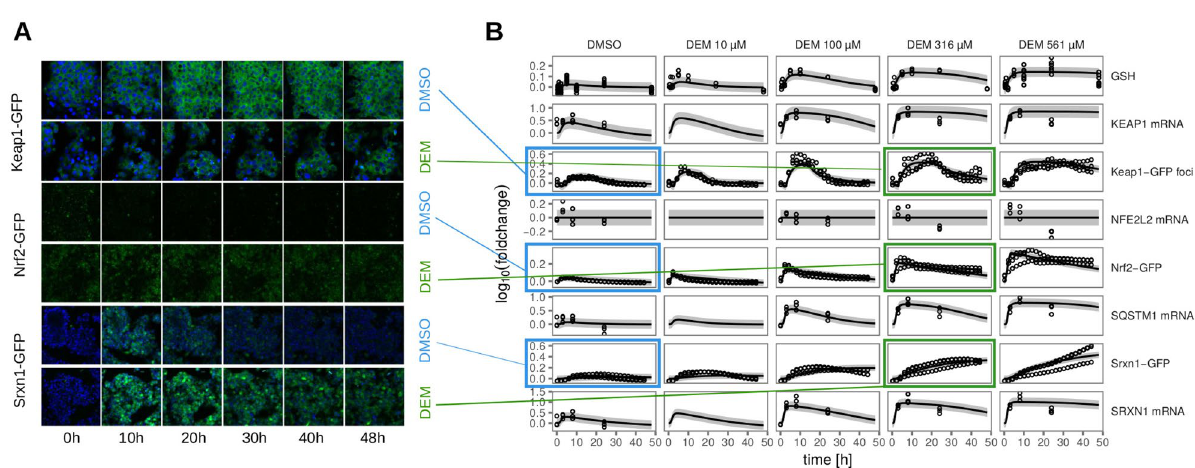
Figure 2. Dynamics of the response to treatment with DEM for 48 h in HepG2 Keap1-GFP, Nrf2-GFP and Srxn1-GFP cell lines. ( A ) Example images of Keap1-GFP, Nrf2-GFP and Srxn1-GFP of 0, 10, 20, 30, 40 and 48 h timepoints for control (DMSO) and 316 µ M DEM and for DMSO. The Hoechst stained nuclei are blue and the GFP signal is green. They are connected to the corresponding panel of B) by blue (DMSO) or green ( 316 µ M DEM) lines. ( B ) 48 h time course exposure with either DMSO or 10, 100, 316 and 561 µ M DEM for different measurements related to the Nrf2 pathway (total GSH measurements, KEAP1, SQSTM1, NFE2L2 and SRXN1 mRNA, Keap1-GFP foci, Nrf2-GFP and Srxn1-GFP). The circles represent the experimental data and the lines represent the trajectories of the fitted model. Shaded areas around the model prediction indicate one standard deviation as estimated by the error